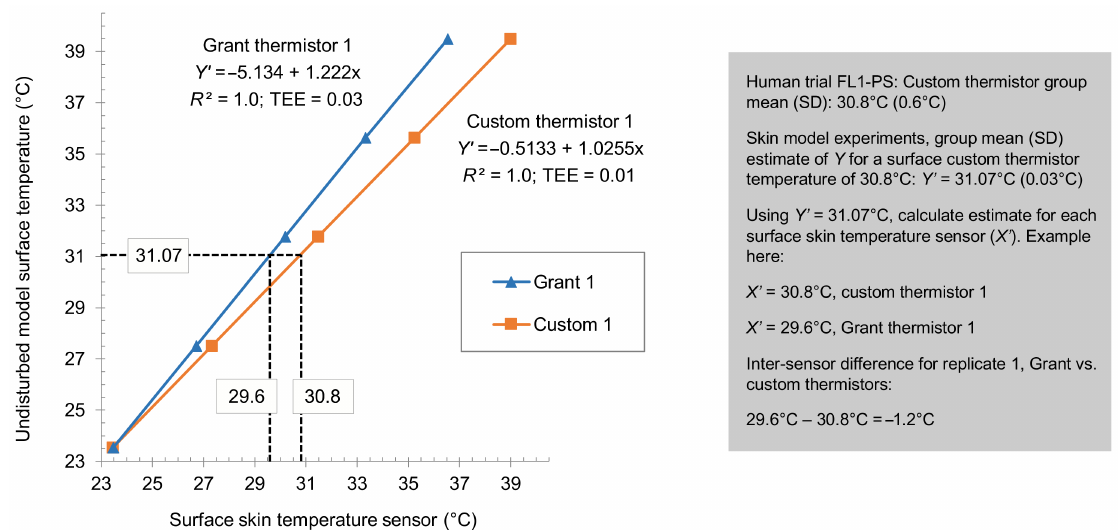
Figure A2. Estimation of required model surface temperature and resultant temperatures of the skin temperature sensors in an example inter-sensor comparison (Grant thermistor vs. custom thermistor). Plotted data are the first replicates for each respective skin temperature sensor in the skin model experiments under the air velocity condition of 0.5 m · s − 1 . See the main text (Section 2.5.3) for more information. FL1-PS, fixed-load cycling 1 pre-sweating; SD, standard deviation; R 2 , coefficient of determination; TEE, typical error of the